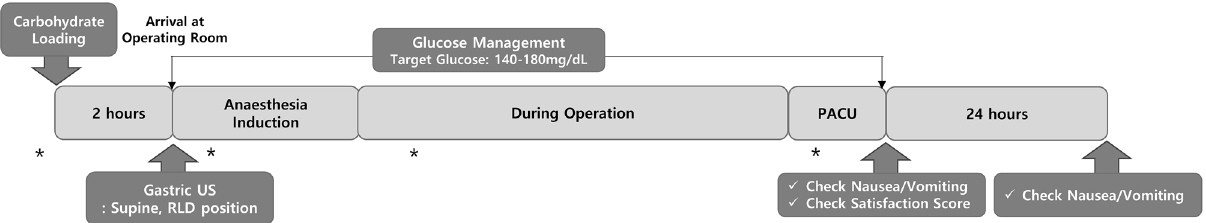
Figure 3. Schematic diagram of the study protocol. RLD, right lateral decubitus; US, ultrasonography; PACU, post anesthesia care unit.; IU, international unit. *Asterisks represent the time points of blood samples for glucose